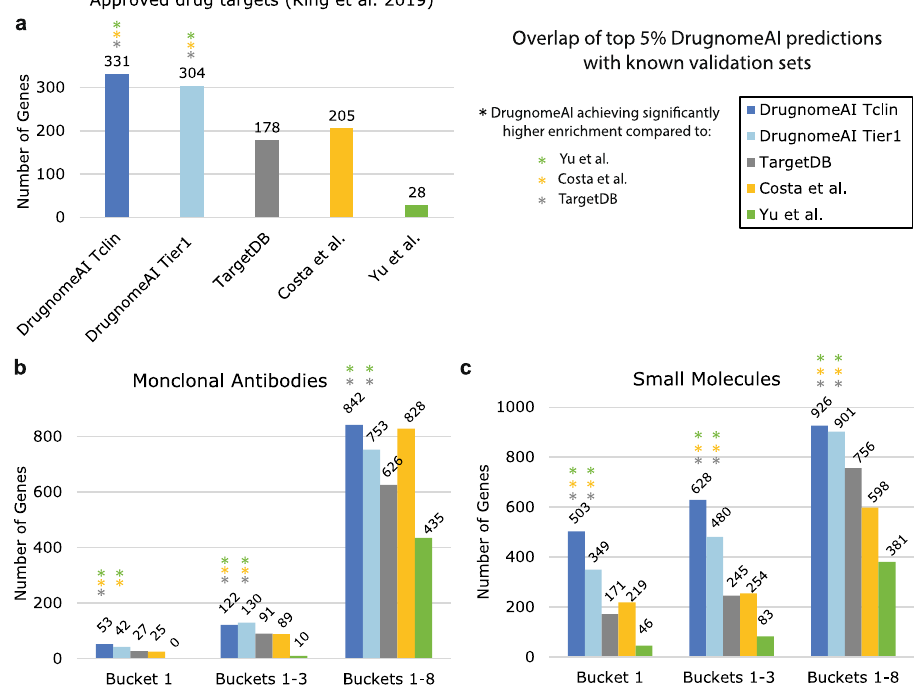
Fig. 6 Overlap between top 5% genes ( n = 992) ranked by DrugnomeAI-Tclin, DrugnomeAI Tier1, TargetDB, Costa et al. and Yu et al. across three validation datasets. Validation of the fi ve models across three validation datasets: ( a ) Approved drug targets (King et al., 2019 dataset). b Open Targets druggability dataset for monoclonal antibodies. c Open Targets druggability data for small molecules. DrugnomeAI has a signi fi cantly more enriched overlap in the majority of pairwise comparisons (39 out of 42 comparisons). Coloured (with grey, yellow and green) asterisks indicate where DrugnomeAI models achieves signi fi cantly higher enrichment with each known validation set compared to TargetDB, Costa et al., and Yu et al., respectively (see also Supplementary Data